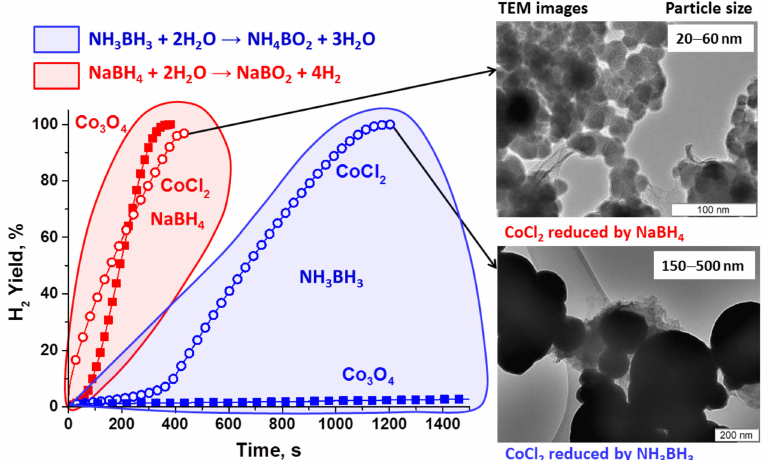
Figure 2. The influence of the nature of the hydride (NaBH 4 , NH 3 BH 3 ) on the formation rate and dispersion of Co-B catalysts forming in situ. The Co-B catalyst instantaneously formed in the NaBH 4 hydrolysis medium has a smaller particle size and shows a higher hydrogen generation